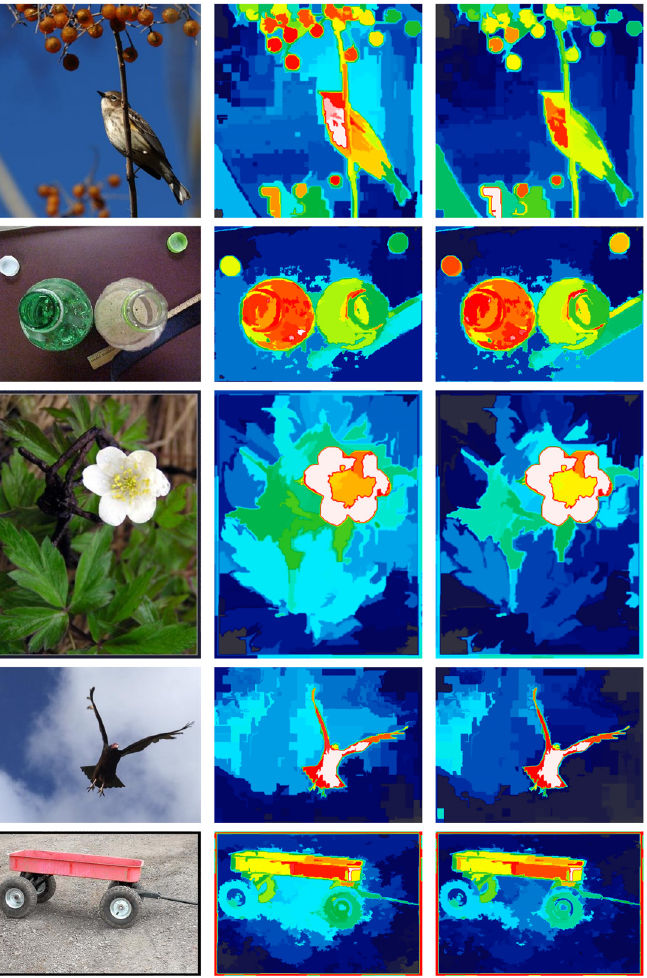
Fig 3. An example illustrating the influence of the implicit center bias in the region contrast method by Cheng et al. [14]. Left-to-right: Image, region contrast (RC) saliency map, and locally debiased region contrast (LDRC) saliency map. As can be seen, RC tends to assign a comparatively high saliency to regions in the center of the image even if these regions exhibit an apparently low perceptual saliency such as, for example, the space between the hand cart ’ s wheels in the bottom